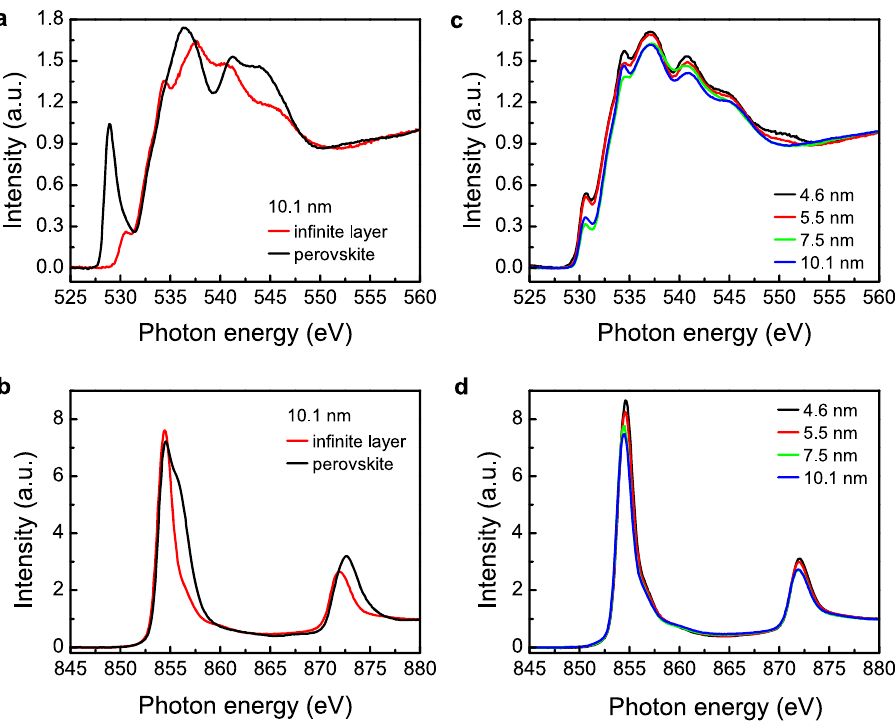
Fig. 3 Thickness dependence of the X-ray absorption spectroscopy. a The O K edge and ( b ) Ni L 2,3 edge XAS of 10.1 nm perovskite Nd 0.8 Sr 0.2 NiO 3 and in fi nite-layer Nd 0.8 Sr 0.2 NiO 2 thin fi lms. c The O K and ( d ) Ni L 2,3 edge of in fi nite-layer Nd 0.8 Sr 0.2 NiO 2 fi lms with different